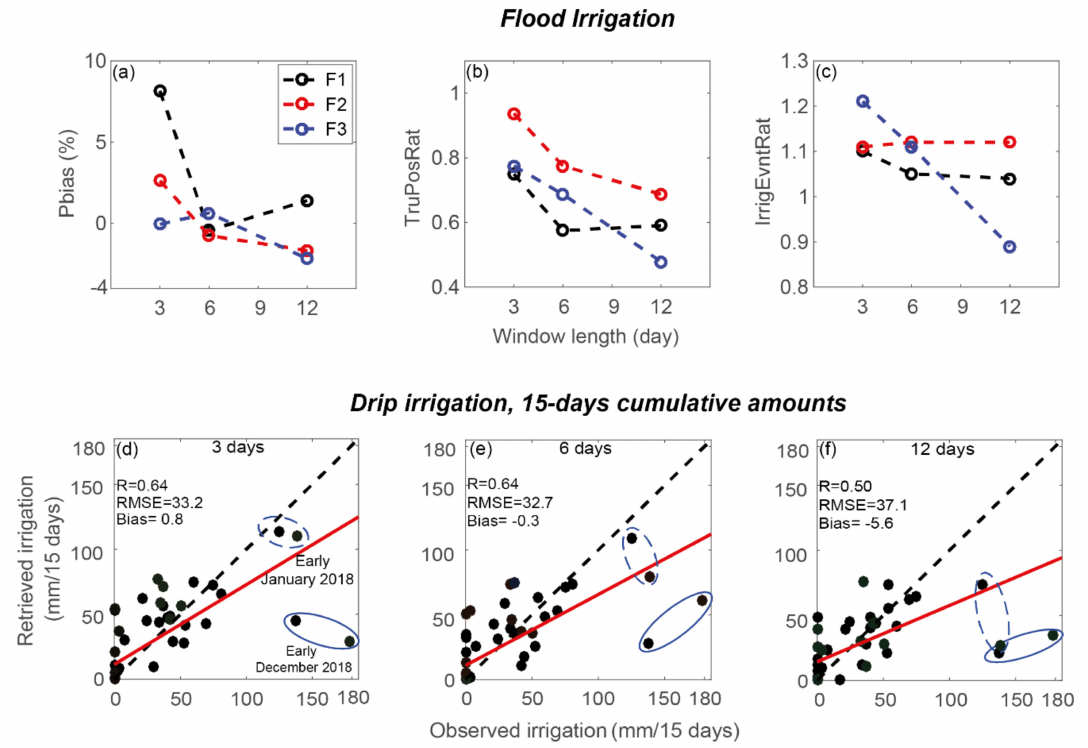
Figure 4. ( a – c ): statistical metrics (Pbias, TruPosRat and IrrigEvntRat) of the flood irrigated fields F1, F2 and F3 for different window lengths: 3-, 6- and 12-day. ( d – f ): statistical metrics (R, RMSE and bias) of the retrieved irrigation versus observed irrigation accumulated by 15 days, over the drip-irrigated fields D1 and D2 both seasons for the three window